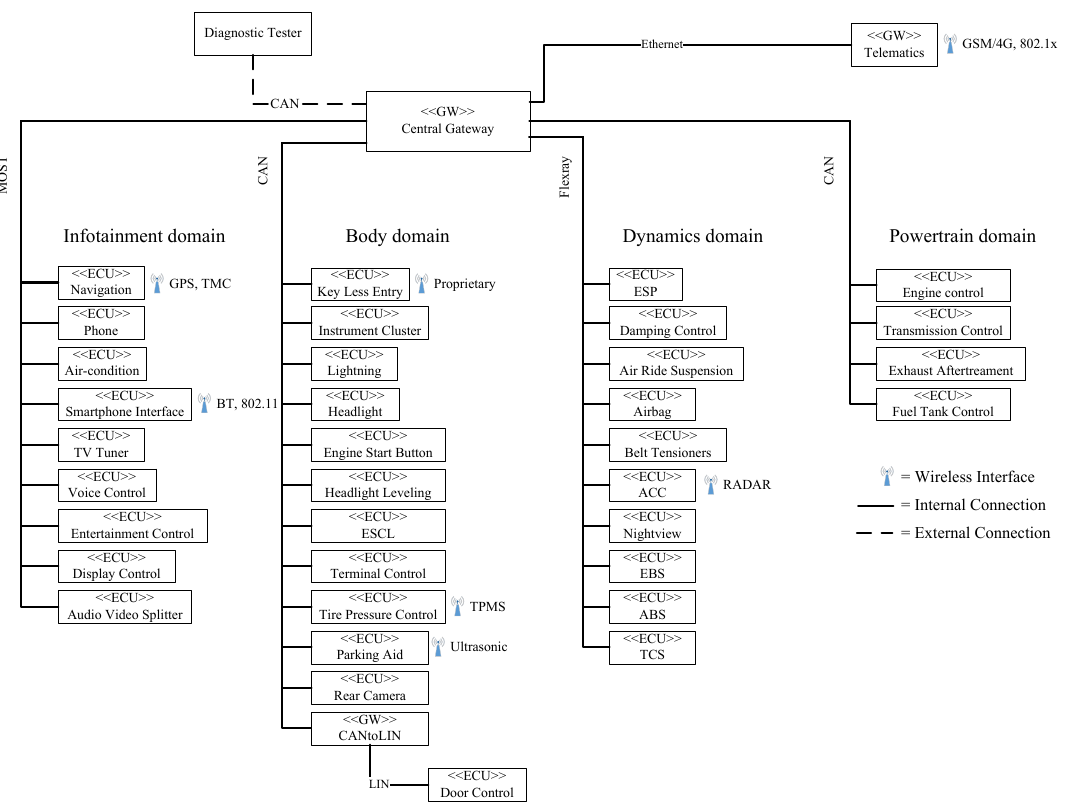
Figure 6. Exemplary Conceptual Automotive